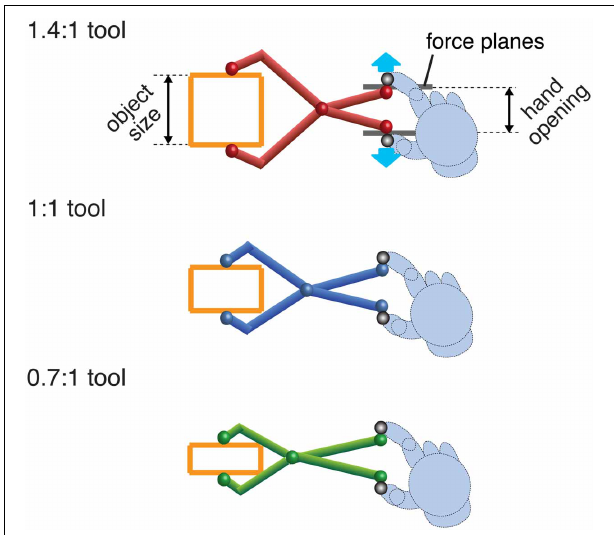
FIGURE 2 | A cartoon of the three different tools used. Tool gain is expressed as the ratio of tool opening (object size) to hand opening. In the experiment the visual tools were rendered using 3D graphics and closely resembled these pictures. Haptic stimuli (force planes) were generated at the hand when the tool-tip touched the object. Note that the hand was not